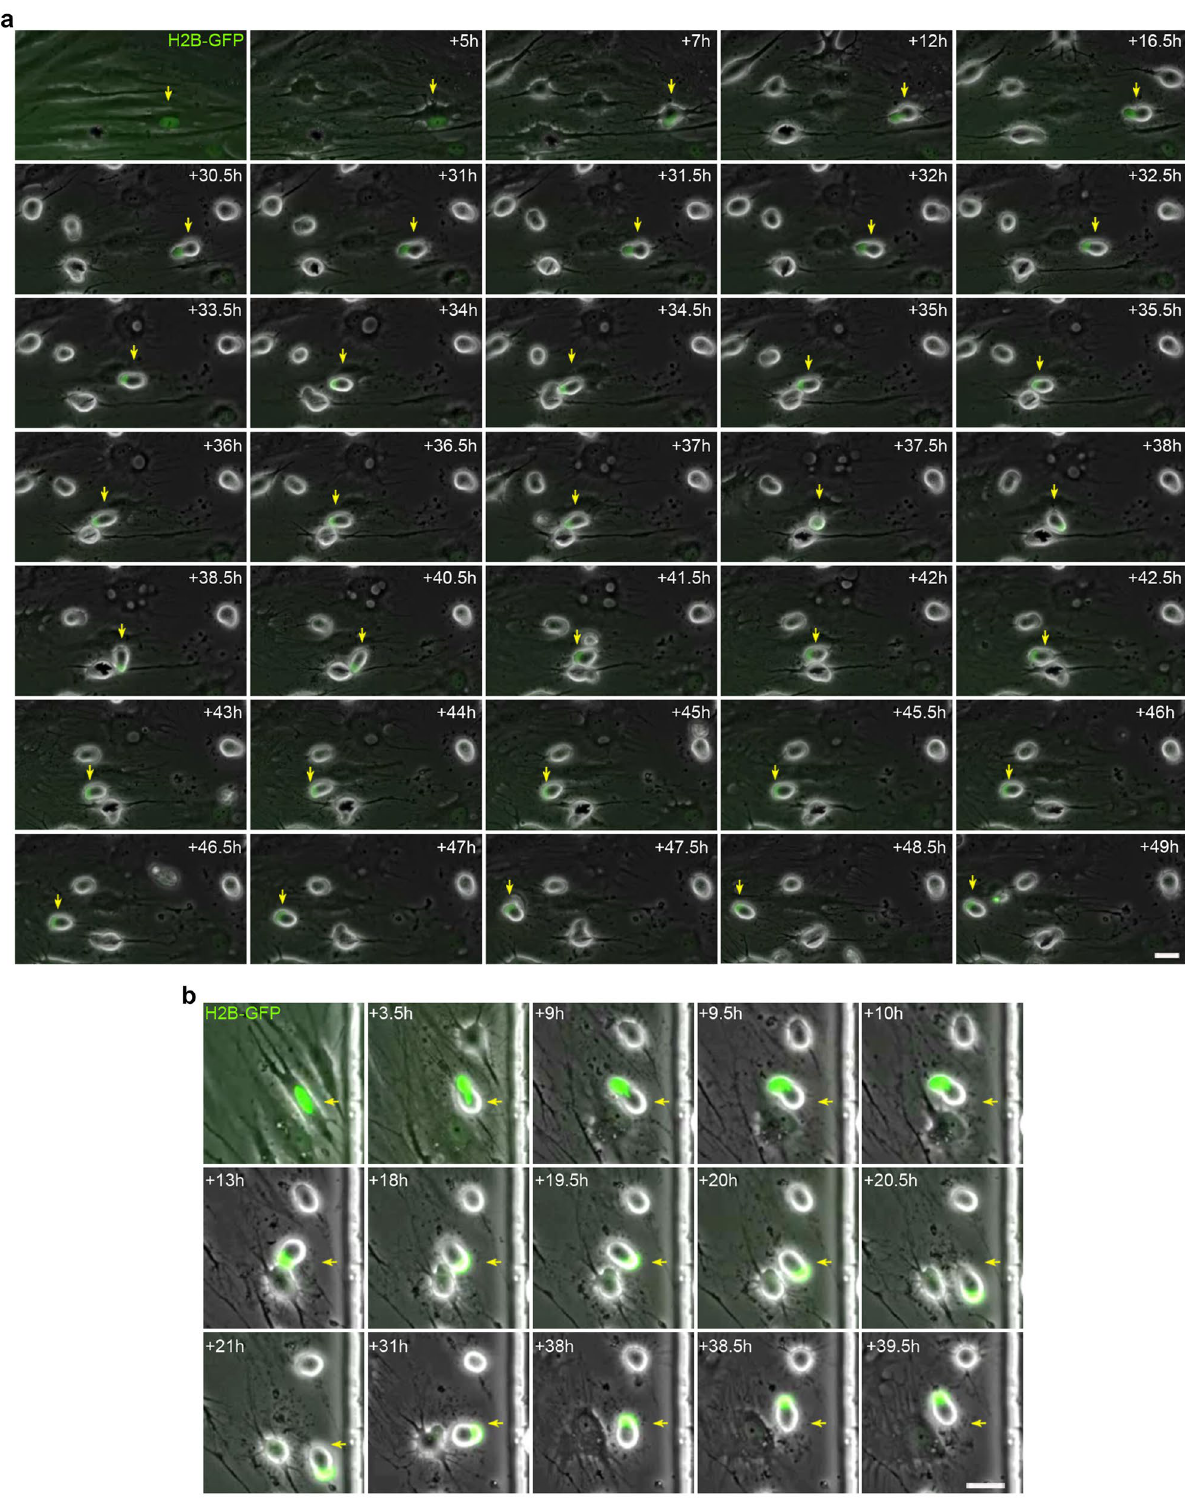
Figure 7. Mononucleated hBM-MSC-derived intermediate cells position their nucleus at the front of the cell during migration. ( a ) Time-lapse microscopy showed that kidney-shaped, histone H2B-GFP-expressing, hBM-MSC-derived intermediate cells positioned their nucleus at the front of the cell during migration. ( b ) In addition, finger-shaped, histone H2B-GFP-expressing, hBM-MSC-derived intermediate cells also positioned their nuclei at the front of the cell during migration. Scale bar: 25